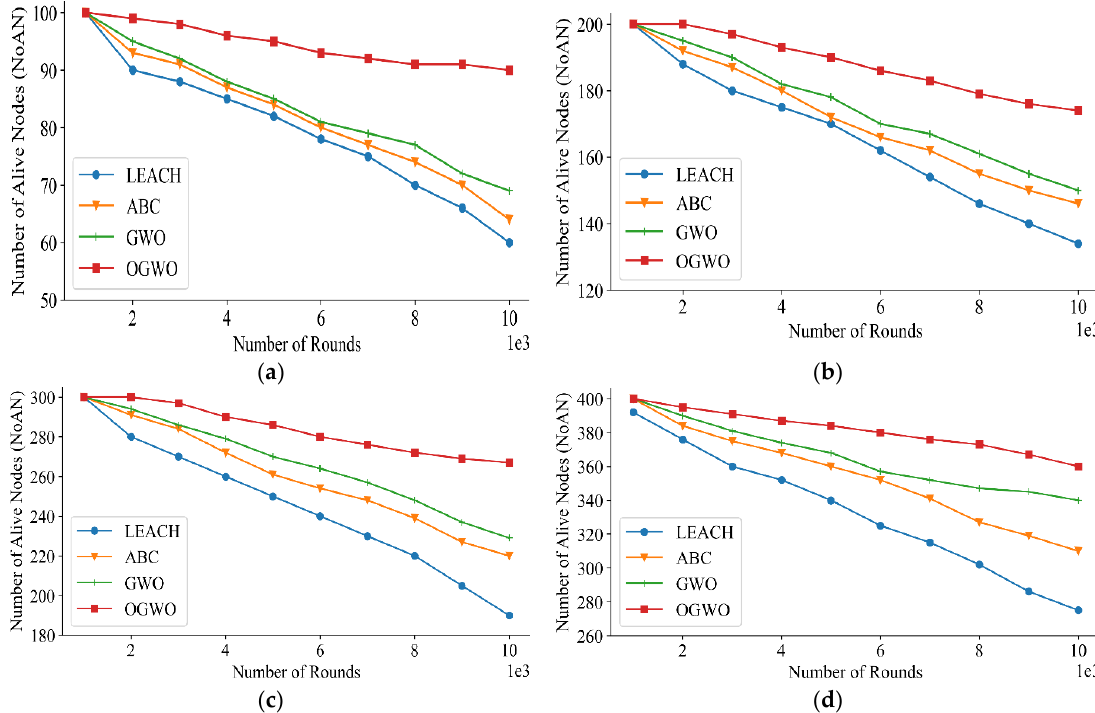
Figure 5. Comparison results of NoAN with respect to number of NCHs = 25%: ( a ) NoAN at NSN = 100 ( b ) NoAN at NSN = 200, ( c ) NoAN at NSN = 300, ( d ) NoAN at NSN = 400.